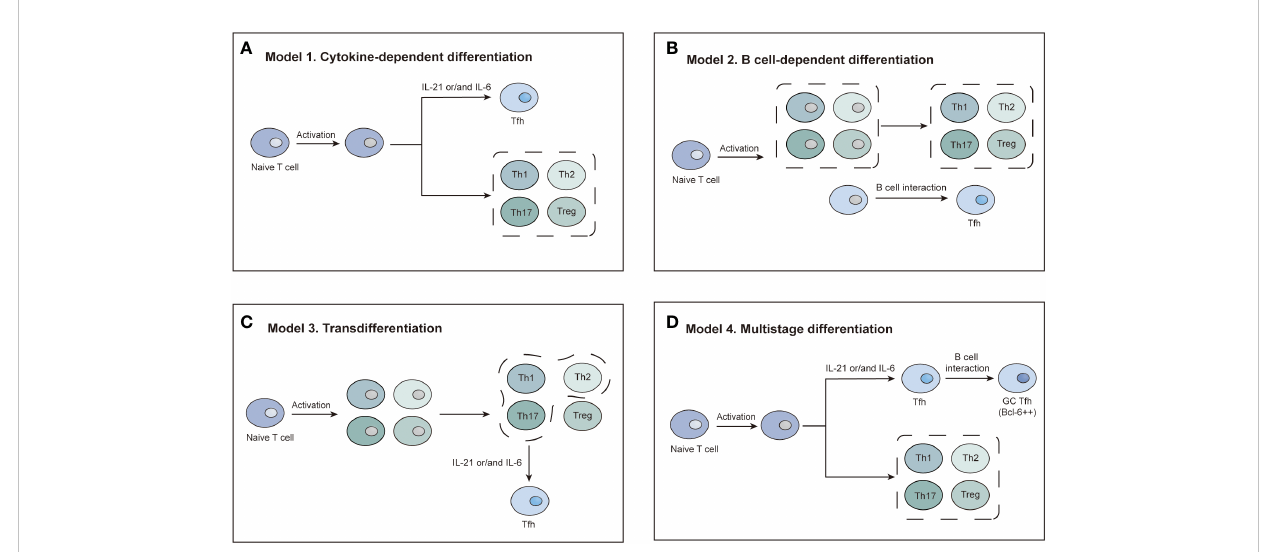
FIGURE 3 Four models of Tfh cell differentiation. (A) Model 1: Activated T cells differentiate into Tfh cells in the presence of IL-21 or IL-6. (B) Model 2: A distinct T-cell subset differentiates into Tfh cells dependent on interaction with B cells. (C) Model 3: Tfh differentiation is a secondary process. Activated T cells fi rst differentiate into four subsets. The Th1, Th2, and Th17 subsets differentiate into Tfh cells via IL-21 or IL-6 induction. (D) Model 4: IL-21/6-induced signaling initiates Tfh cell differentiation. Complete polarization occurs after primary Tfh cells enter the germinal center and interact with B